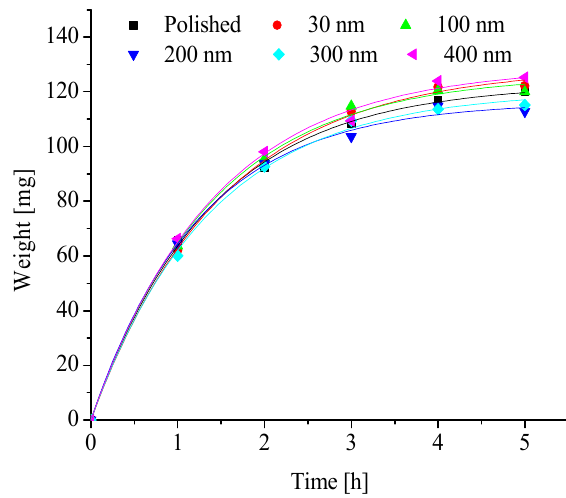
Figure 31. Testing value exponential model regression fitting at T = − 25 °C, φ = 90%.